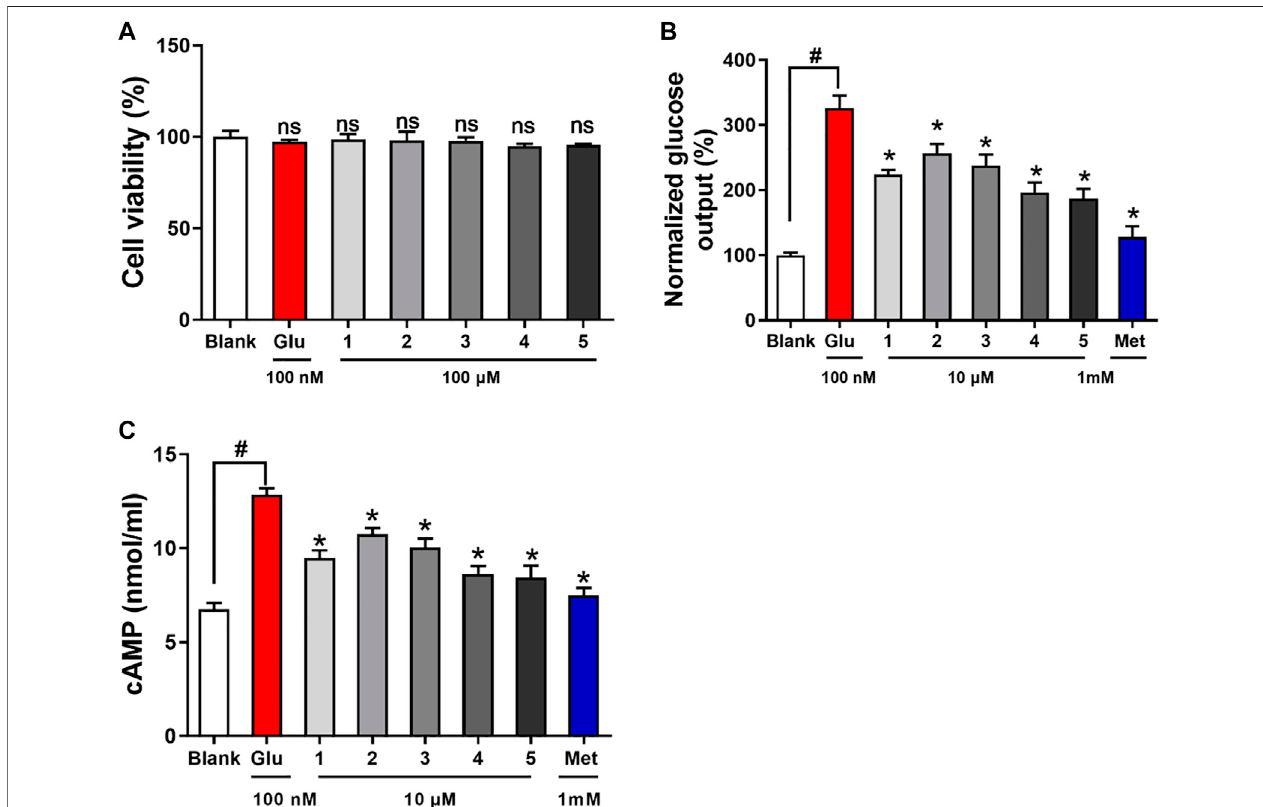
FIGURE 5| Viability and anti-diabetic effectsof compounds 1 – 5 against HepG2 cells. (A) : cell viability (B) : hepatic glucose production level; (C) : cAMPcontents in HepG2 cells treated with glucagon (Glu, 100 nM). ns p ＞ 0.05 vs. Blank, * p < 0.05 vs. Glu, # p < 0.05 vs.